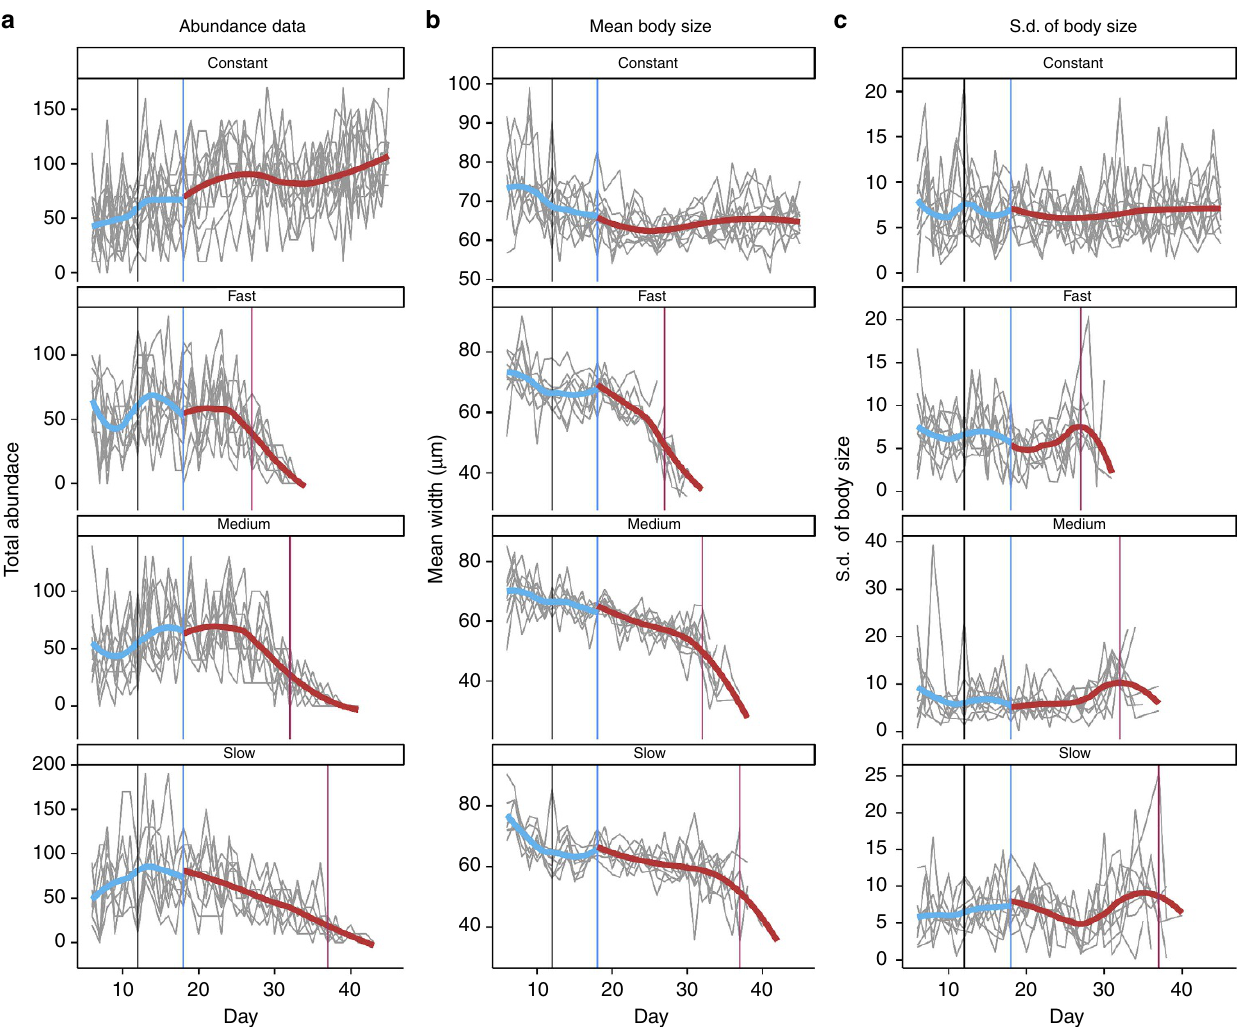
Figure 2 | Effects of experimental treatments on Didinium abundances and body size. Data on the abundance ( a ) mean body size ( b ) and s.d. of the body size ( c ) of D. nastrum populations that were exposed to four different experimental treatments were collected over a period of 45 days. Populations in declining food availability treatments showed significant shifts in body size before population collapse. Black vertical lines indicate the end of the transitory dynamics phase (day 12). Blue vertical lines indicate the start of the experimental treatments (day 18). Red vertical lines indicate the last day that prey were added in each treatment (where applicable). Loess smoothing shows the general responses of populations in each of the four treatments from the start of the monitoring period to the beginning of the experimental treatments (days 6–12, light blue lines), and from the start of the experimental treatments to the extinction of the last experimental population (day 12 onwards, red